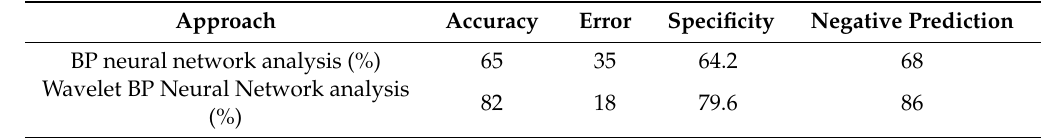
Table 9. Pitch failure model prediction performance